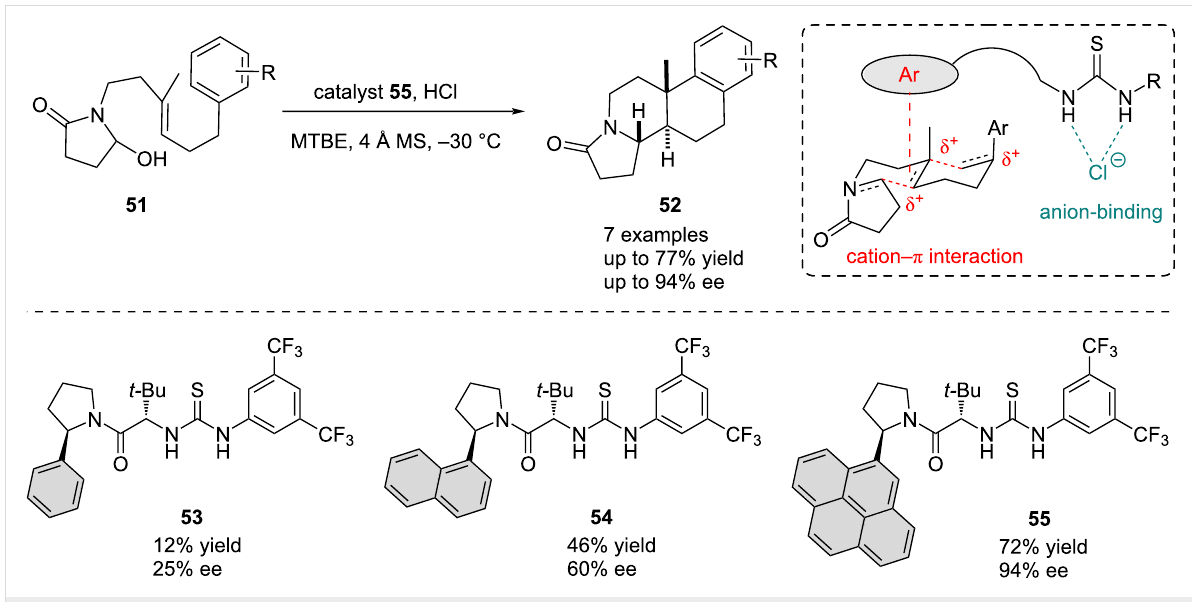
Scheme 11: Thiourea-catalyzed enantioselective polycyclization reaction of hydroxylactams 51 through cation– π